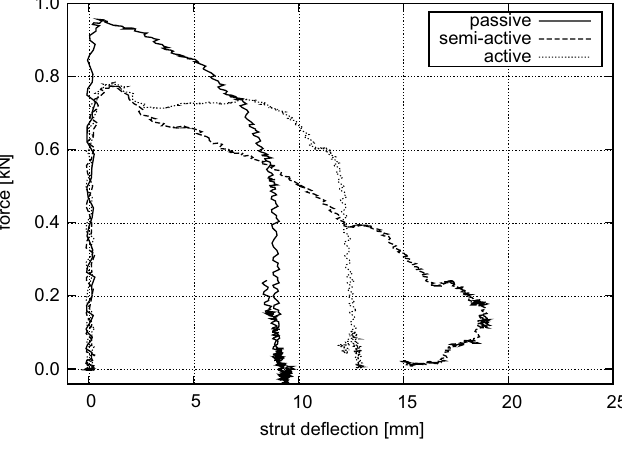
Fig. 22. Measured force versus deflection at the passive, semi-active and active control strategy for m = 27 kg and v 0 = 0 . 85 m / s (drop height 37